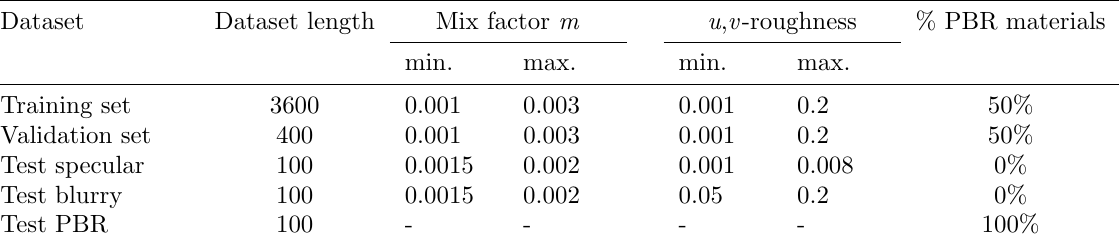
Table 1: Dataset lengths, materials and